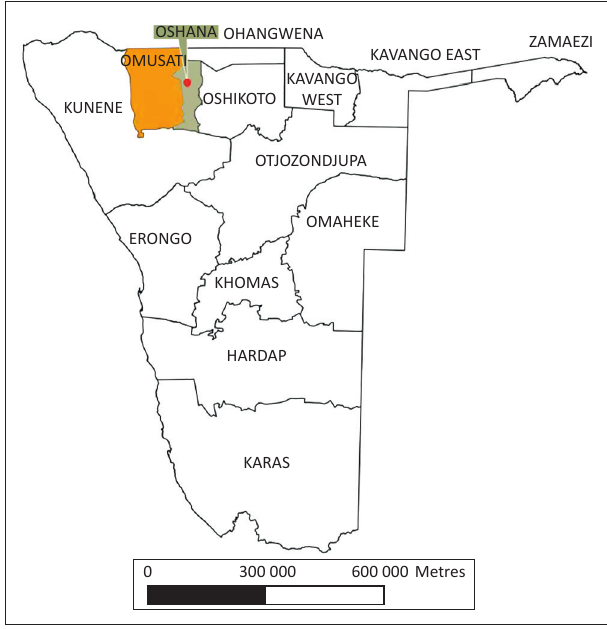
TABLE 2: Main source of